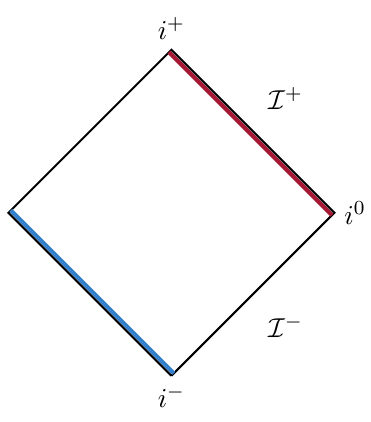
Figure 2. The O ± ( w, ¯ w ) correspond to light ray integrals of operator insertions at I ± . For fixed ∆ ,J ( w, ¯ w ) this is illustrated by the antipodally placed blue (past) and red (future) contours.